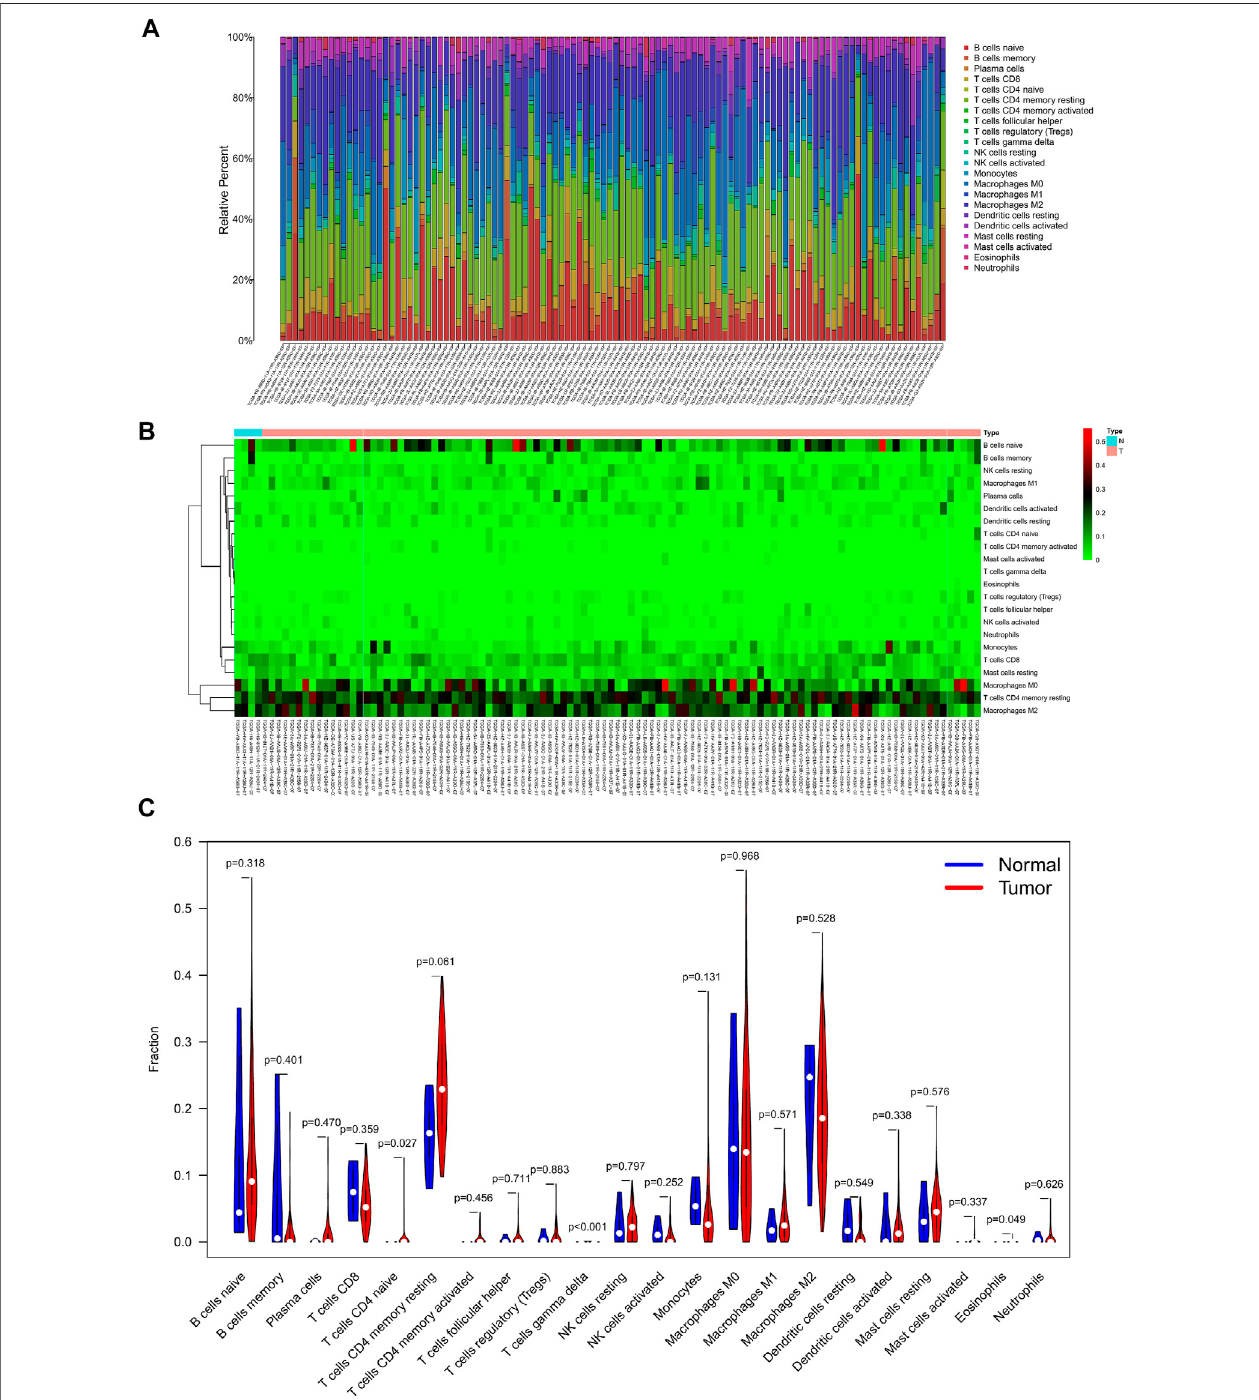
FIGURE 7 | Composition (A) and heatmap (B) of 22 subsets of immune cells in PAAD; violin plot (C) of immune cell in fi ltration in tumor and normal groups.